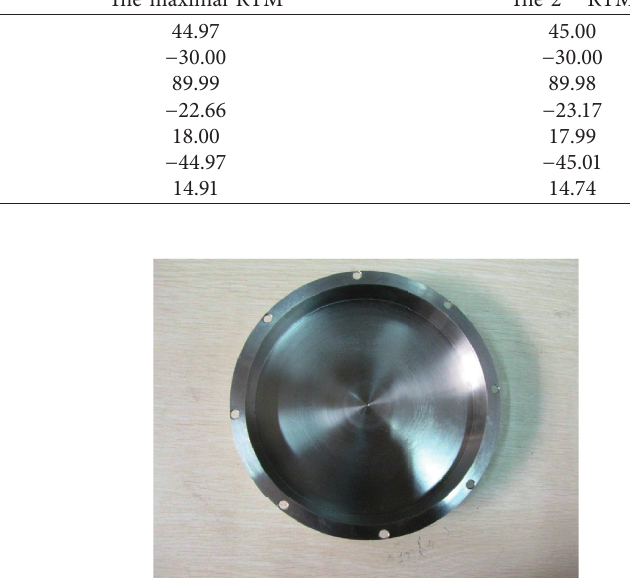
Figure 9: Cover structure.